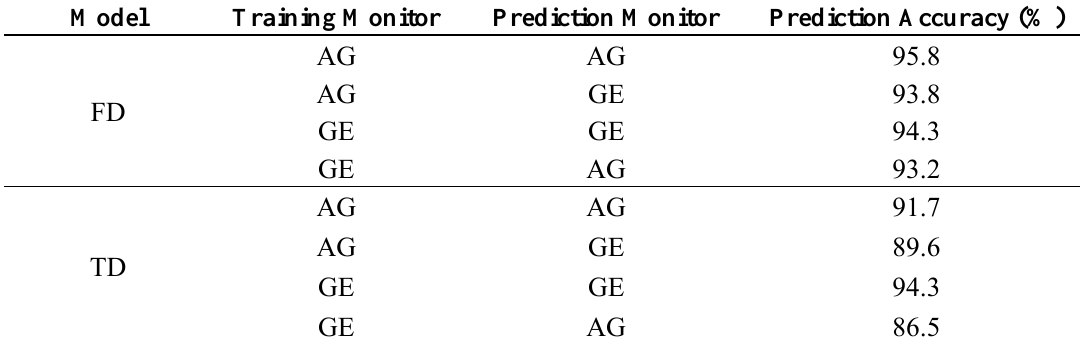
Table 1. Overall activity type classification accuracy when a model developed on data from one monitor is applied to data from the same monitor and the other monitor.